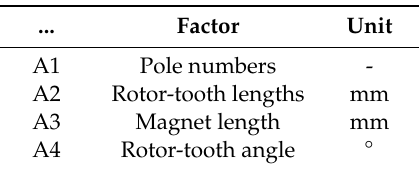
(cid:16) (cid:17) 8 5 8